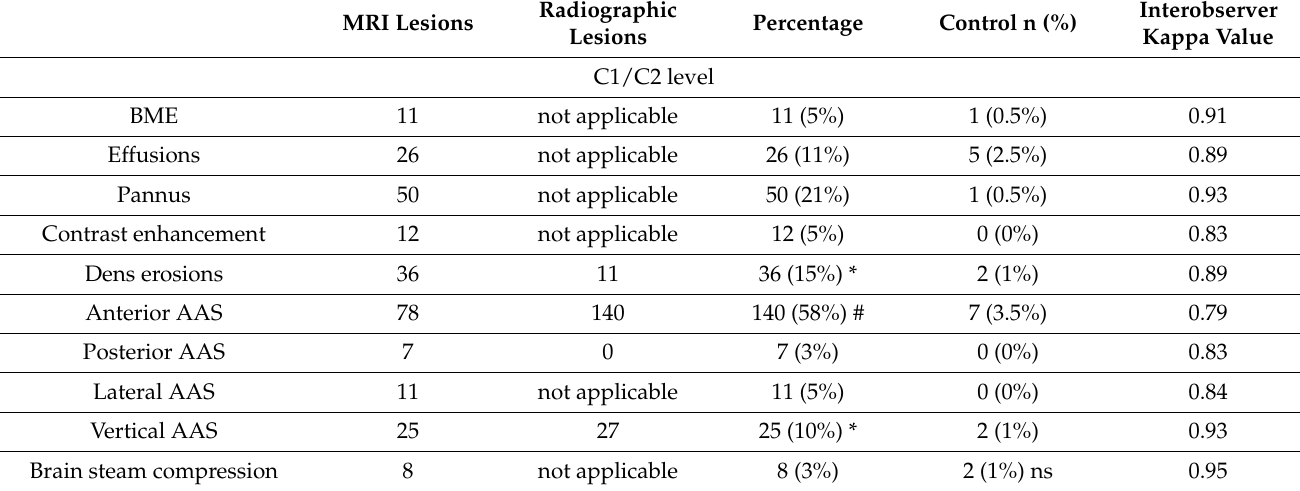
Table 1. Prevalence of pathologies in the study group. * MRI results are presented as a gold standard, # Radiography findings are presented as a gold standard as a study providing dynamic assessment of subluxations, contrary to static MRI, $ Ankylosis is present, when detected by at least one method. AAS: atlanto-axial subluxation, BME: bone marrow edema, MRI: magnetic resonance imaging, ns: not significant (difference between rheumatoid arthritis and control group), SAS: subaxial